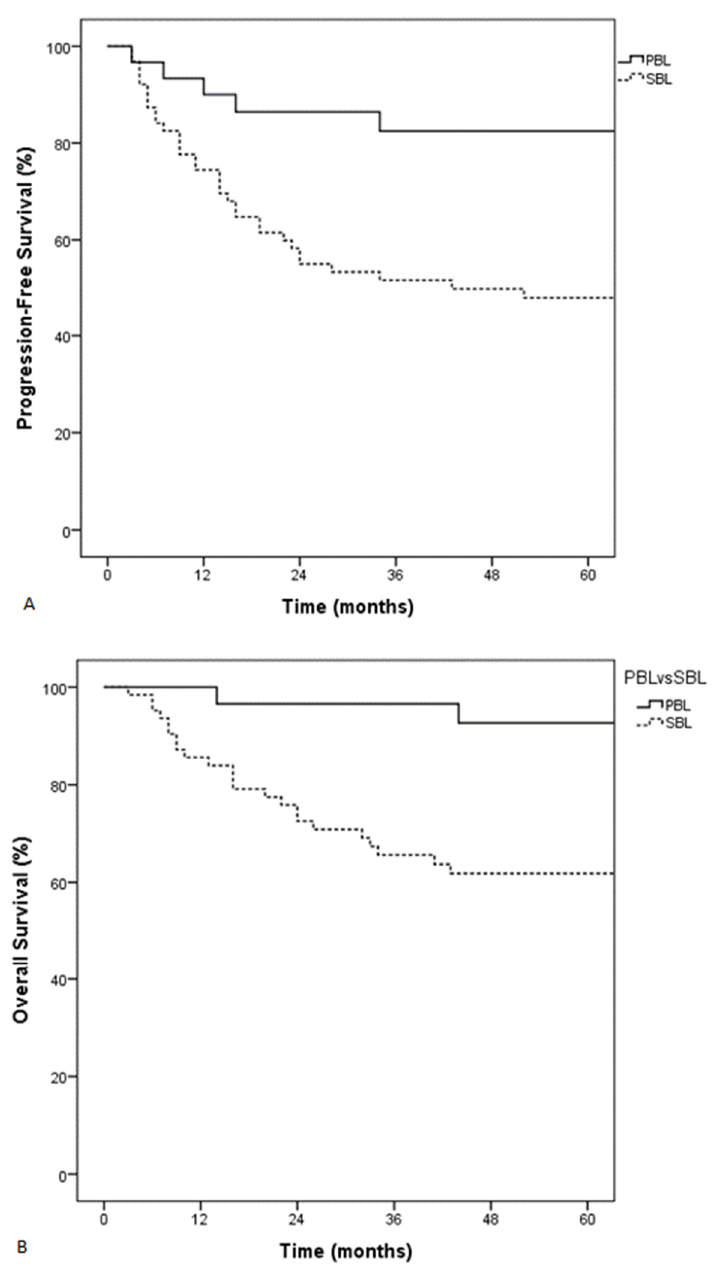
Figure 1. Progression-free survival (PFS) ( A ) and overall survival (OS) ( B ) according to the type of skeletal involvement. PBL, Primary Bone Lymphoma; SBL, Secondary Bone Lymphoma. Table 3. Univariable analysis of factors associated with PFS and OS.